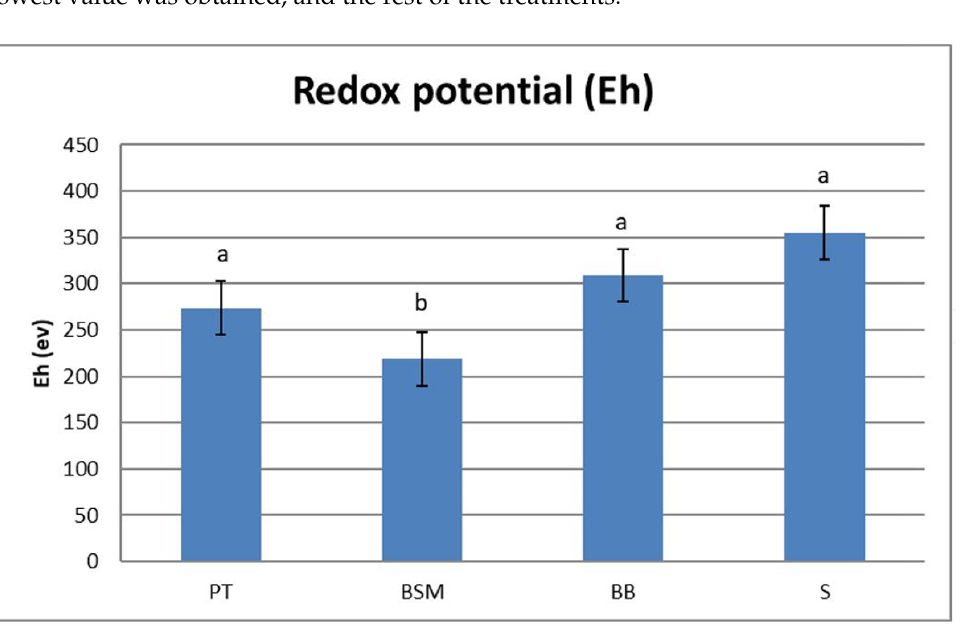
Figure 2. Average Eh values in the soil during the solarization period. “a” and “b” indicate significant differences between treatments at the 95% confidence level.